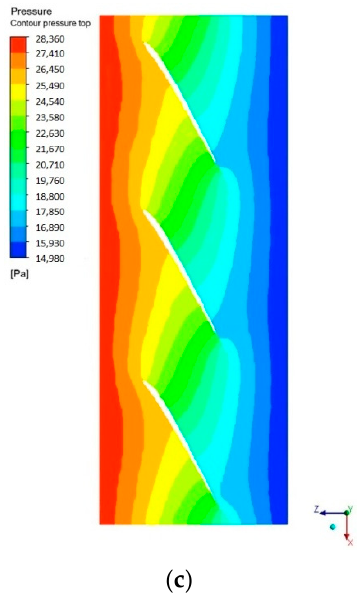
Figure 10. Comparison of the steam pressure distribution at 95% of the blade height. ( a ) Cold blade shape; ( b ) ideal blade shape; ( c ) hot blade shape.